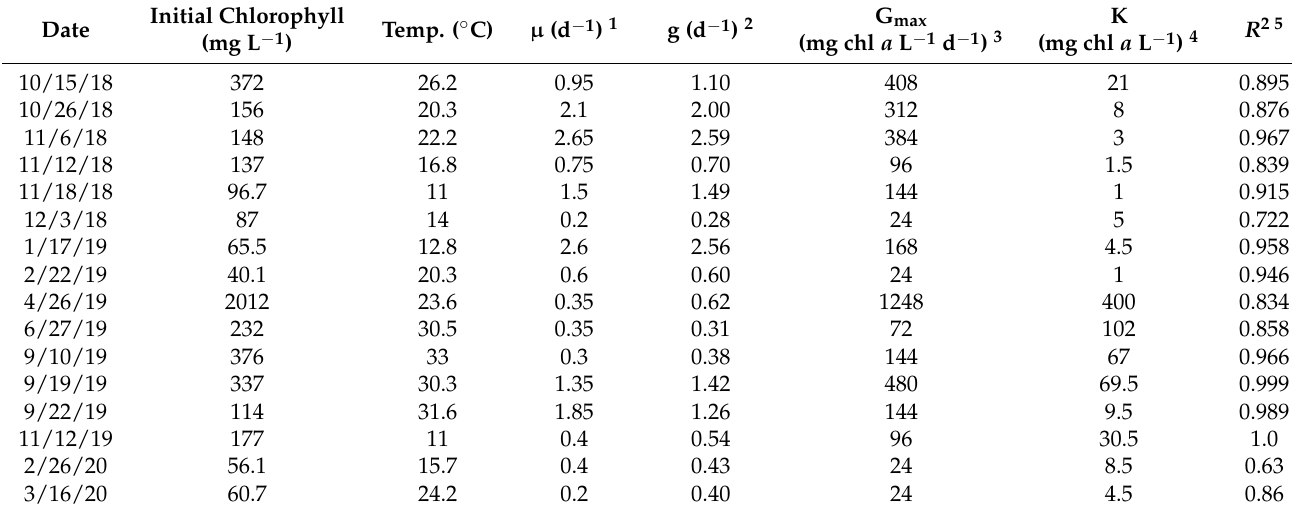
Table A1. Summary of results of 16 dilution experiments conducted in University